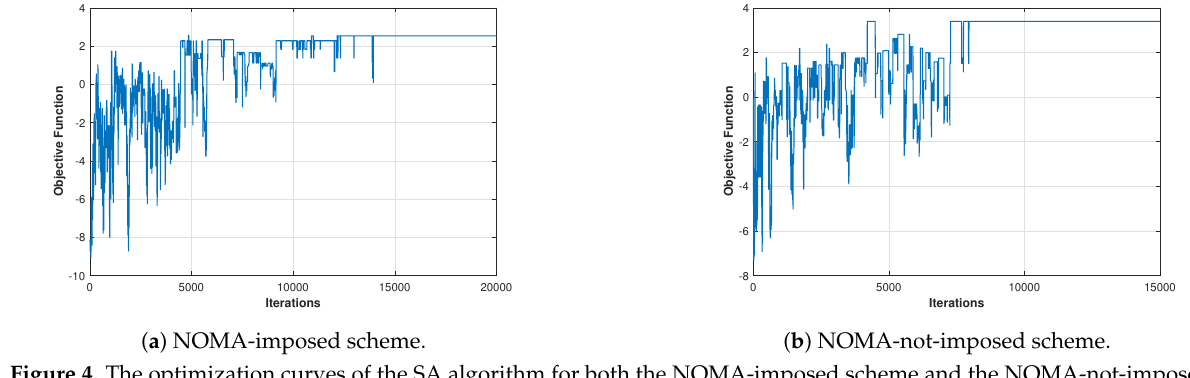
Figure 4. The optimization curves of the SA algorithm for both the NOMA-imposed scheme and the NOMA-not-imposed scheme for one users’ location realization. ( P e = 35 dBm, L = 4, N = 10, K = 16, φ 1/2 = 60 ◦ , Ψ 1/2 = 85 ◦